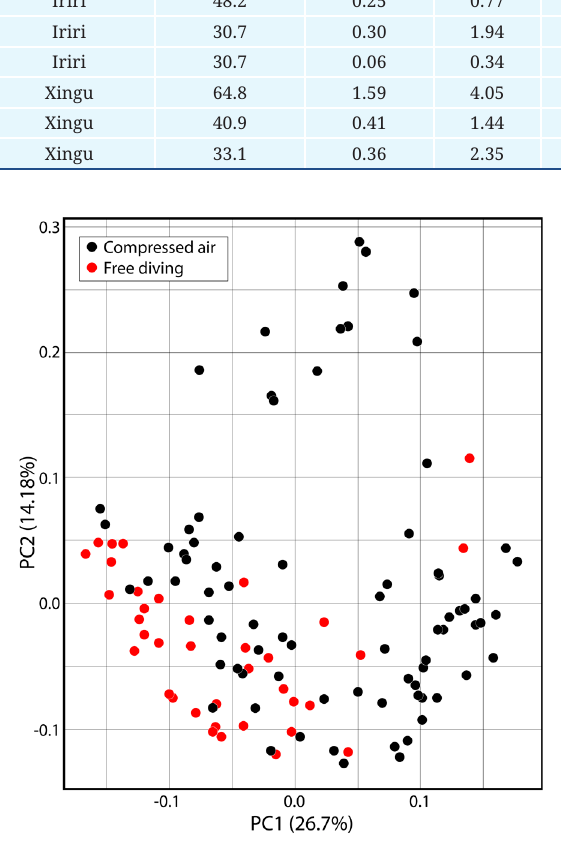
FIGURE 3 | Principal component analysis (PCA) for composition of ornamental fish species based on the method of capture (Hellinger transformation), considering the two extractive